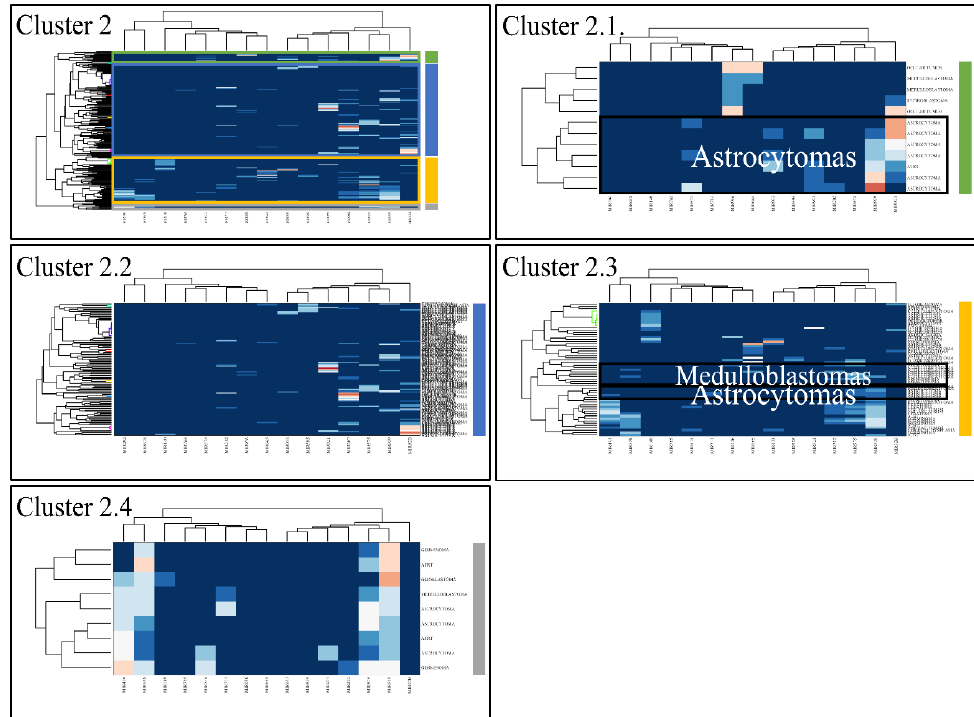
Figure 5. Hierarchical clustering (HCL) of cluster 2 as revealed previously by k-means clustering. The complete HCL is presented (Cluster 2) with its respective sub-clusters, denoted as clusters 2.1, 2.2, 2.3 and 2.4. In sub-cluster 2.3 miRNAs grouped together astrocytomas and medulloblastomas.